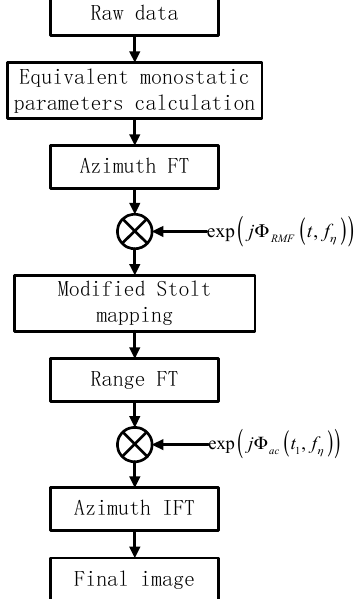
Figure 5. Bistatic FMCW SAR image processing flow diagram.